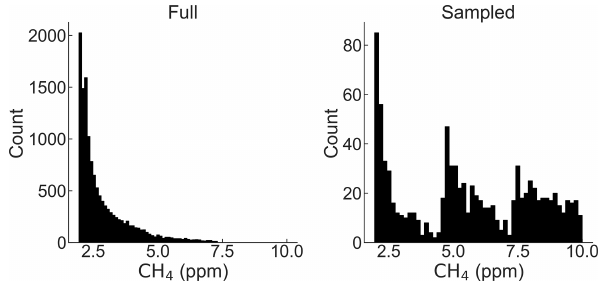
Figure 5. Distributions of the full and sampled dataset. The full dataset has n = 14065 points. The sampled dataset has n = 930